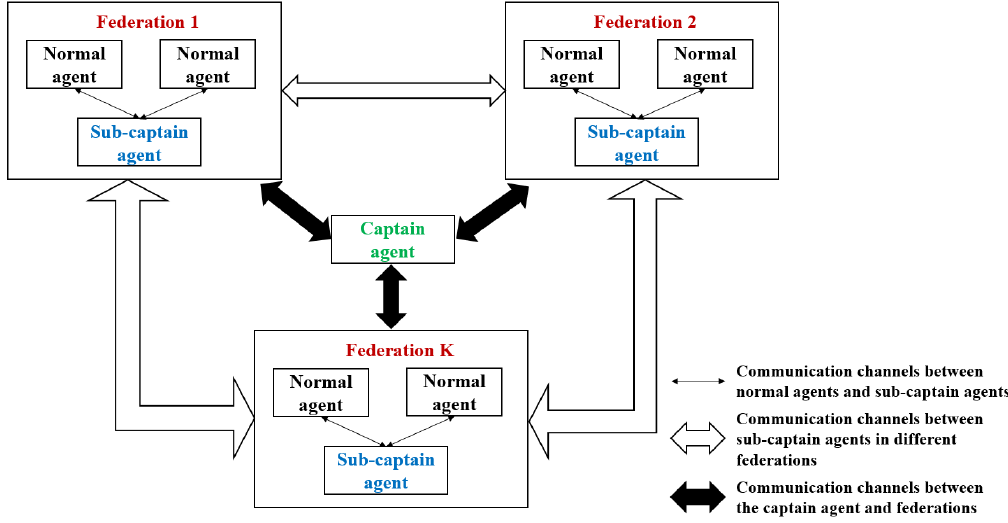
Figure 4. An improved architecture for precision farming system.